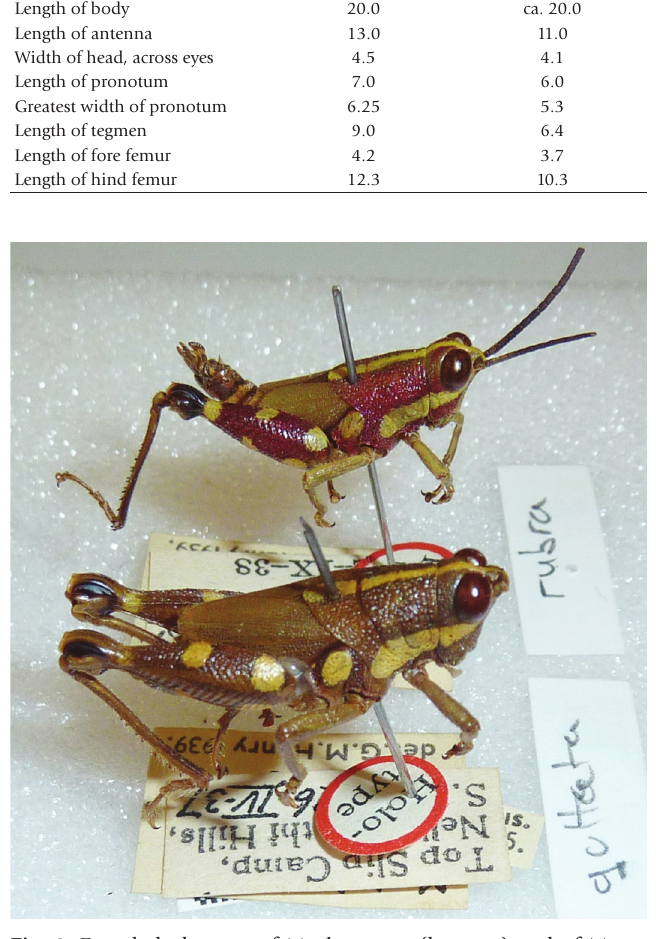
Fig. 3. Female holotypes of Mopla guttata (bottom) and of M. ru- bra (top), showing the slightly smaller size and distinctly redder ground coloration of M. rubra. Photo credit: L.D.C.